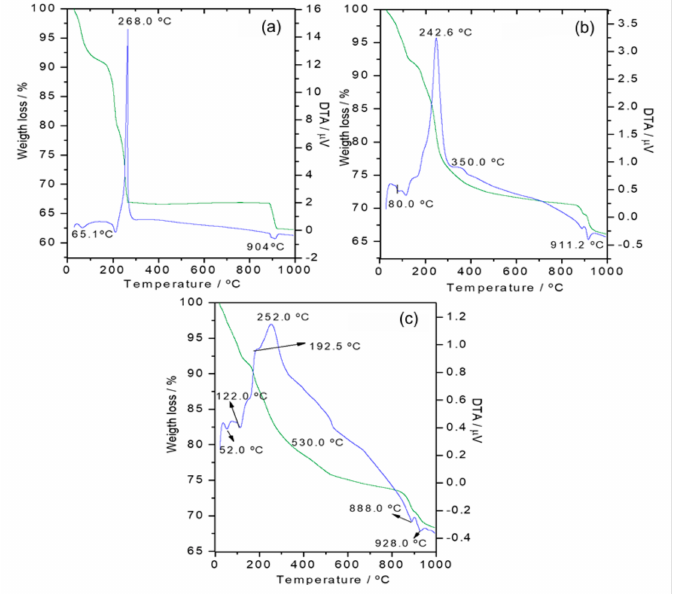
Figure 10. TG and DTA curves of ( a ) Co-LSH, and ( b ) Z-LSH_cppt and ( c ) Z-LSH_ie biohybrids carried out under air